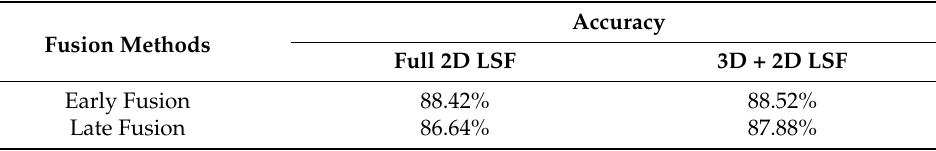
Table 7. Different data augment performance of the full 2D ResNet-18 and 3D + 2D ResNet-18 on LRW dataset. Results are reported in terms of RANK 1 identification accuracy